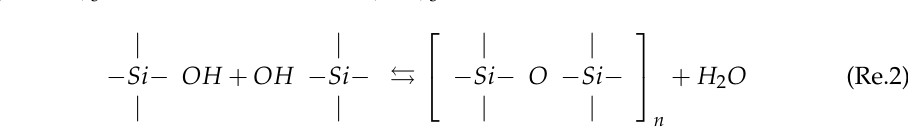
Table 3. Corrosion rate of steel samples and protective effect in various electrolytes. Media V cor , mg/dm 2 /day Background solution